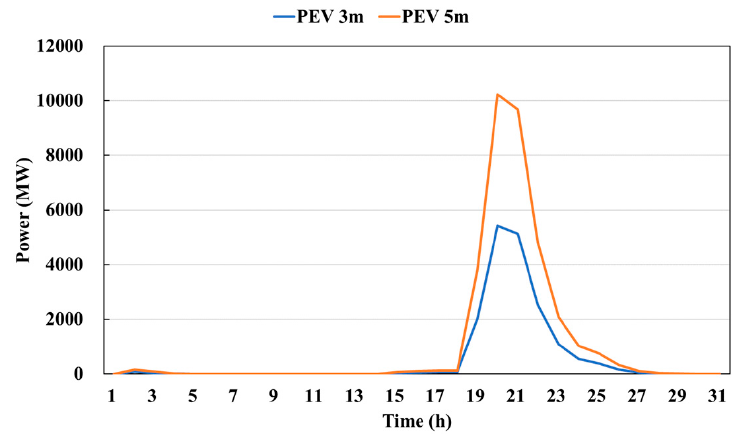
Figure 12. Daily charging profile of total PEVs in Korean power system.